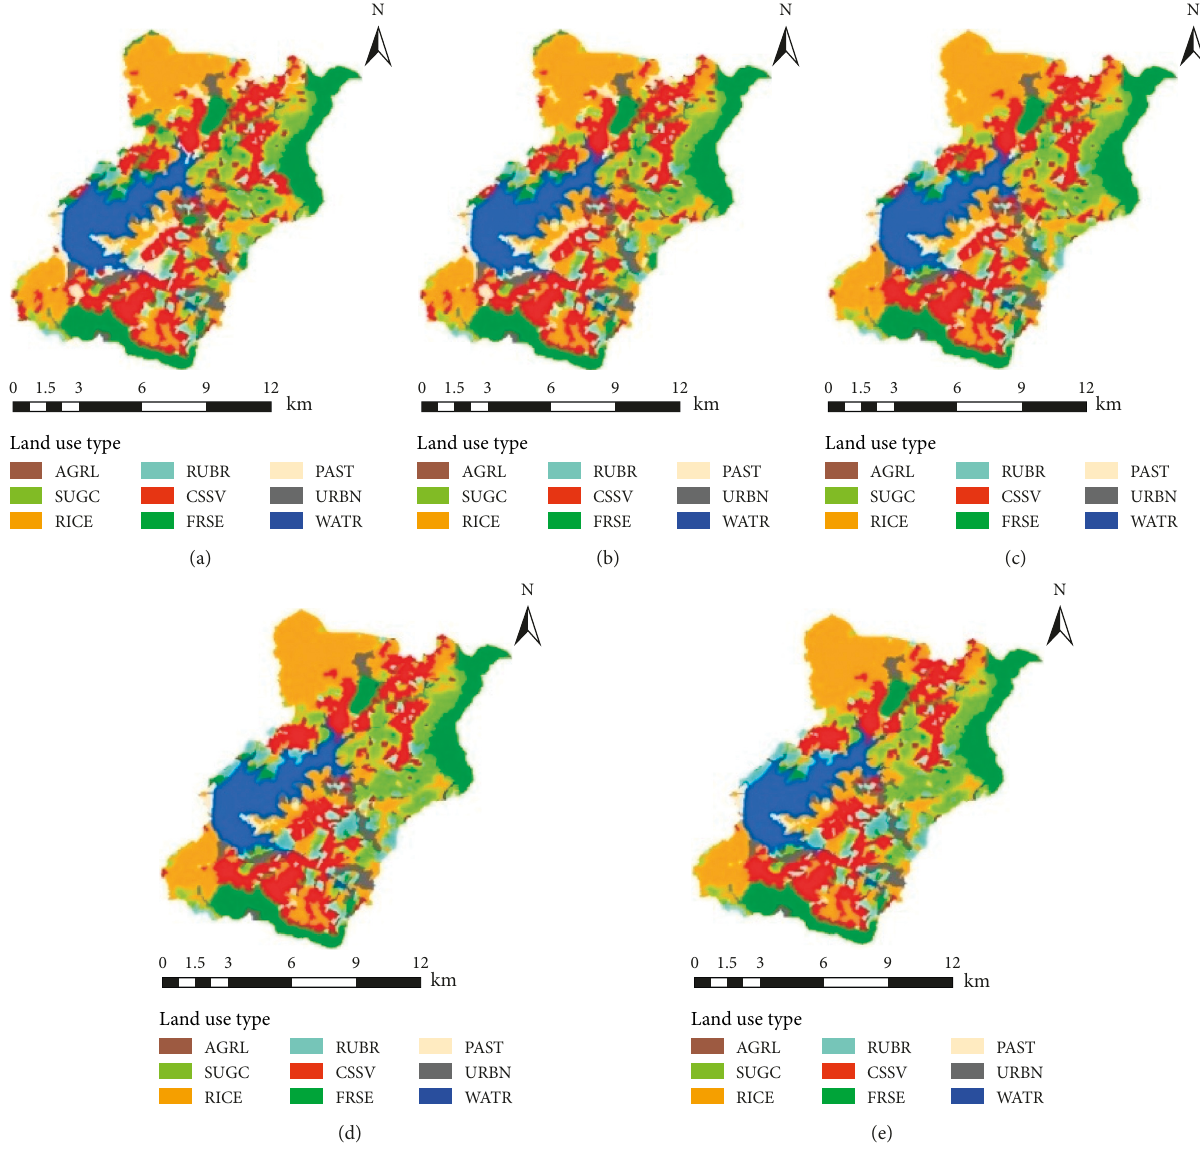
Figure 13: HistoricalandsimulatedlanduseareasabovetheHuaySabagareabyparticipationprocess.(a)Year2024.(b)Year2038.(c)Year2052.(d) Year 2066. (e) Year